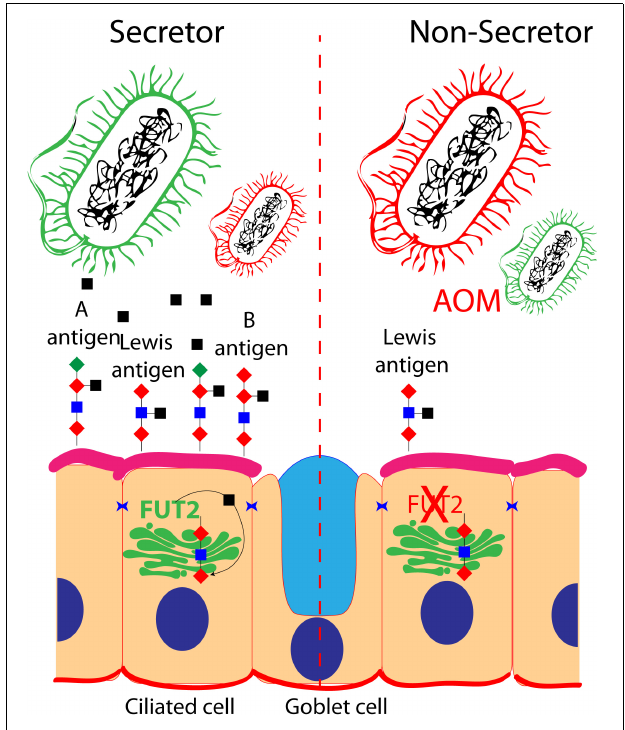
FIGURE 2 | Protein pathways contributing to otitis media (OM) in human: hypothetical network of human proteins in the middle ear mucosa that have been associated with OM. When these proteins are dysfunctional due to OM-associated genetic variants, they could potentially have an impact on the microbiota of the middle ear